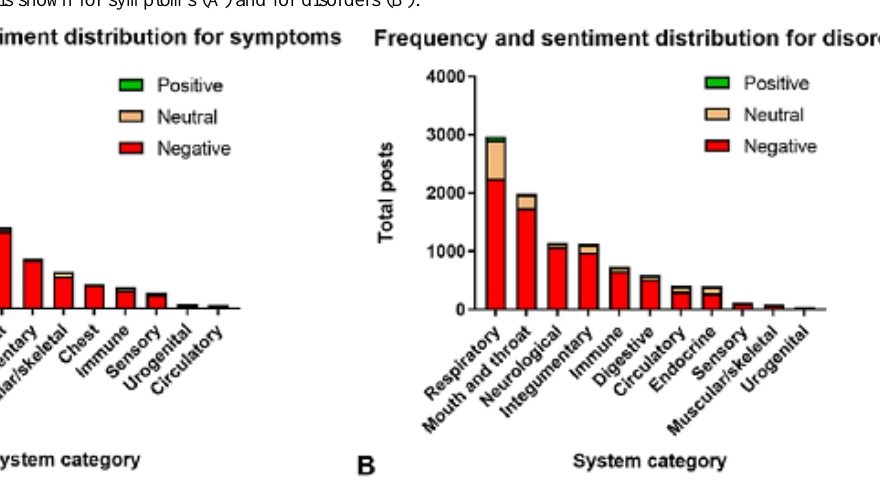
Figure 2. Frequency distribution of reported symptom (A) and disorder (B) posts grouped into their systems or anatomical regions. The frequency of positive, neutral, and negative posts is shown for symptoms (A) and for disorders